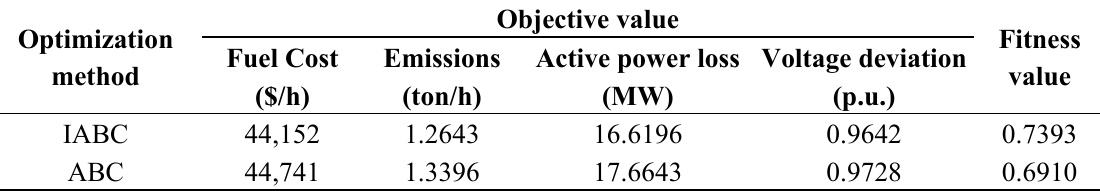
Table 9. Best solutions obtained by the different algorithms for fuzzy multi-objective OPF for the IEEE 57-bus system.